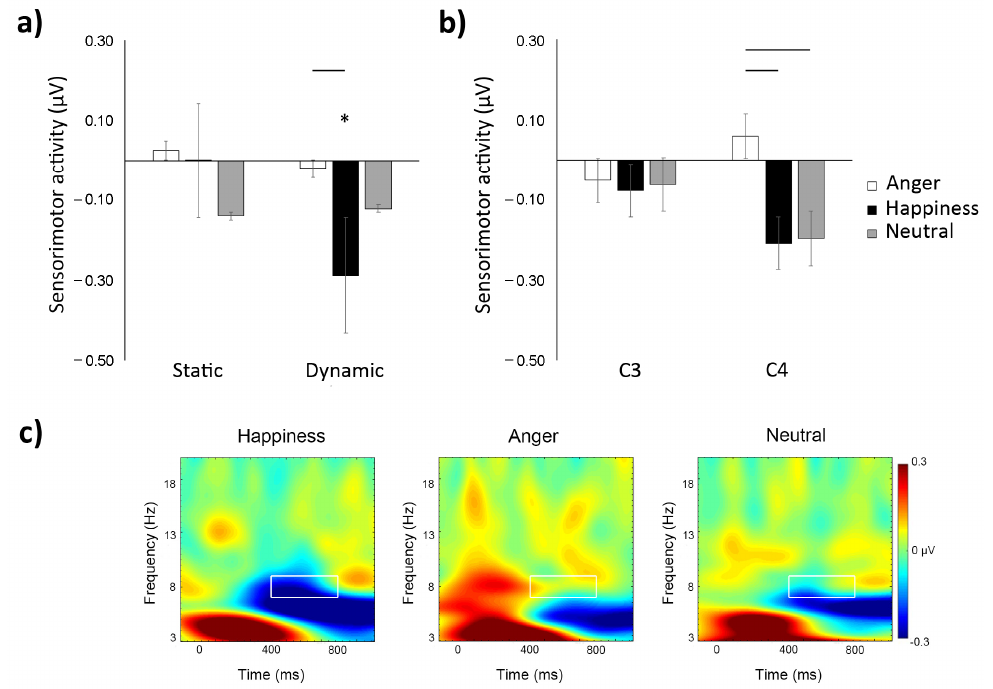
Figure 2. Illustrations of time–frequency results. The upper panels ( a , b ) display mean alpha activity over the selected electrode clusters covering sensorimotor areas during the observation of static and dynamic neutral, happy, and angry facial expressions. Significant suppression from baseline and significant comparisons between conditions are illustrated, * p < 0.05. Error bars represent the standard errors of the means. In the bottom panel ( c ), time–frequency plots display baseline-corrected activity respectively for dynamic happy, angry, and neutral faces over sensorimotor areas (i.e., C3 and C4).